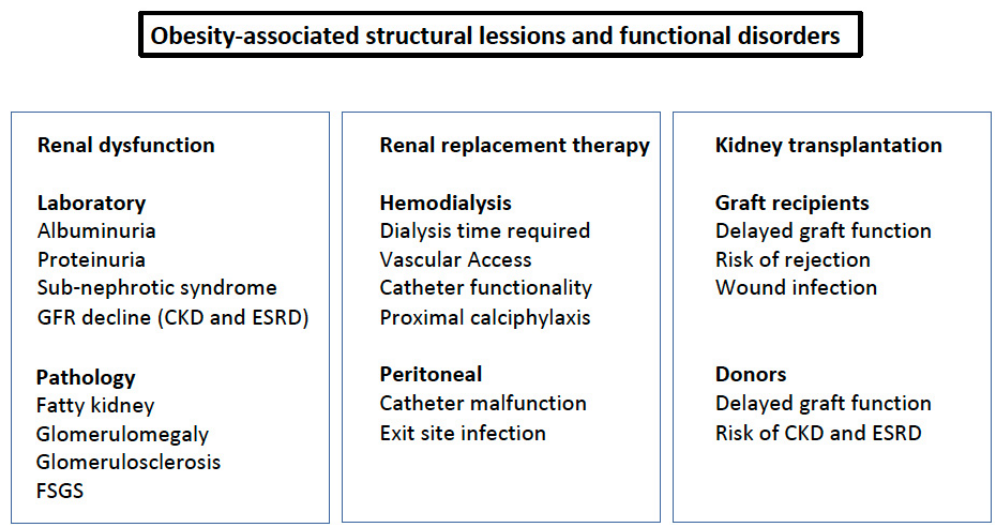
Figure 2. Obesity-associated structural lesions and functional disorders. FSGS: focal segmentary glomerulosclerosis.